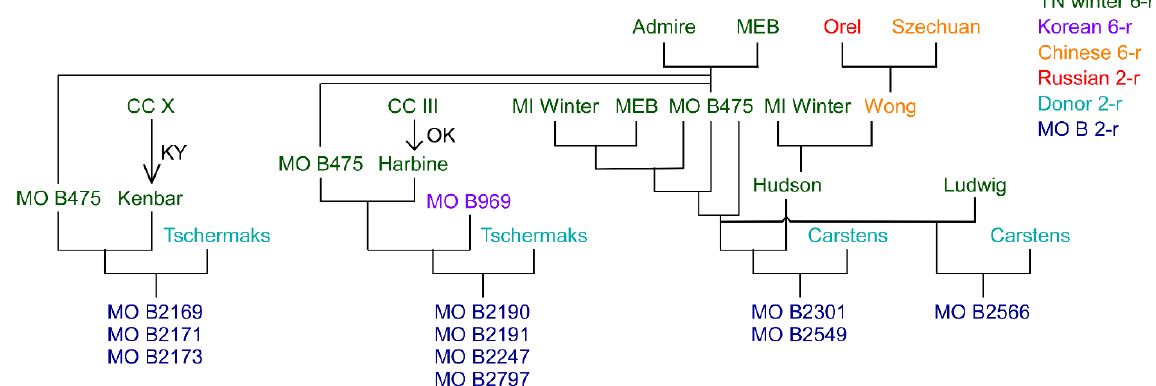
Figure 2. Pedigree of the two-row winter lines developed by Poehlman. ‘Kenbar’ and ‘Harbine’ are derived from Composite Cross X (CC X) and CC III, respectively. Composite cross populations were created by crossing a set of parental lines to one another in all possible combinations. Equal quantities of F 2 seed from each F 1 were then bulked and sent to barley breeders throughout the U.S., who then made selections in their environments. For example, CC III (CI 5530) was produced from crosses between 13 barley accessions, including winter, facultative, and spring types [64,75].